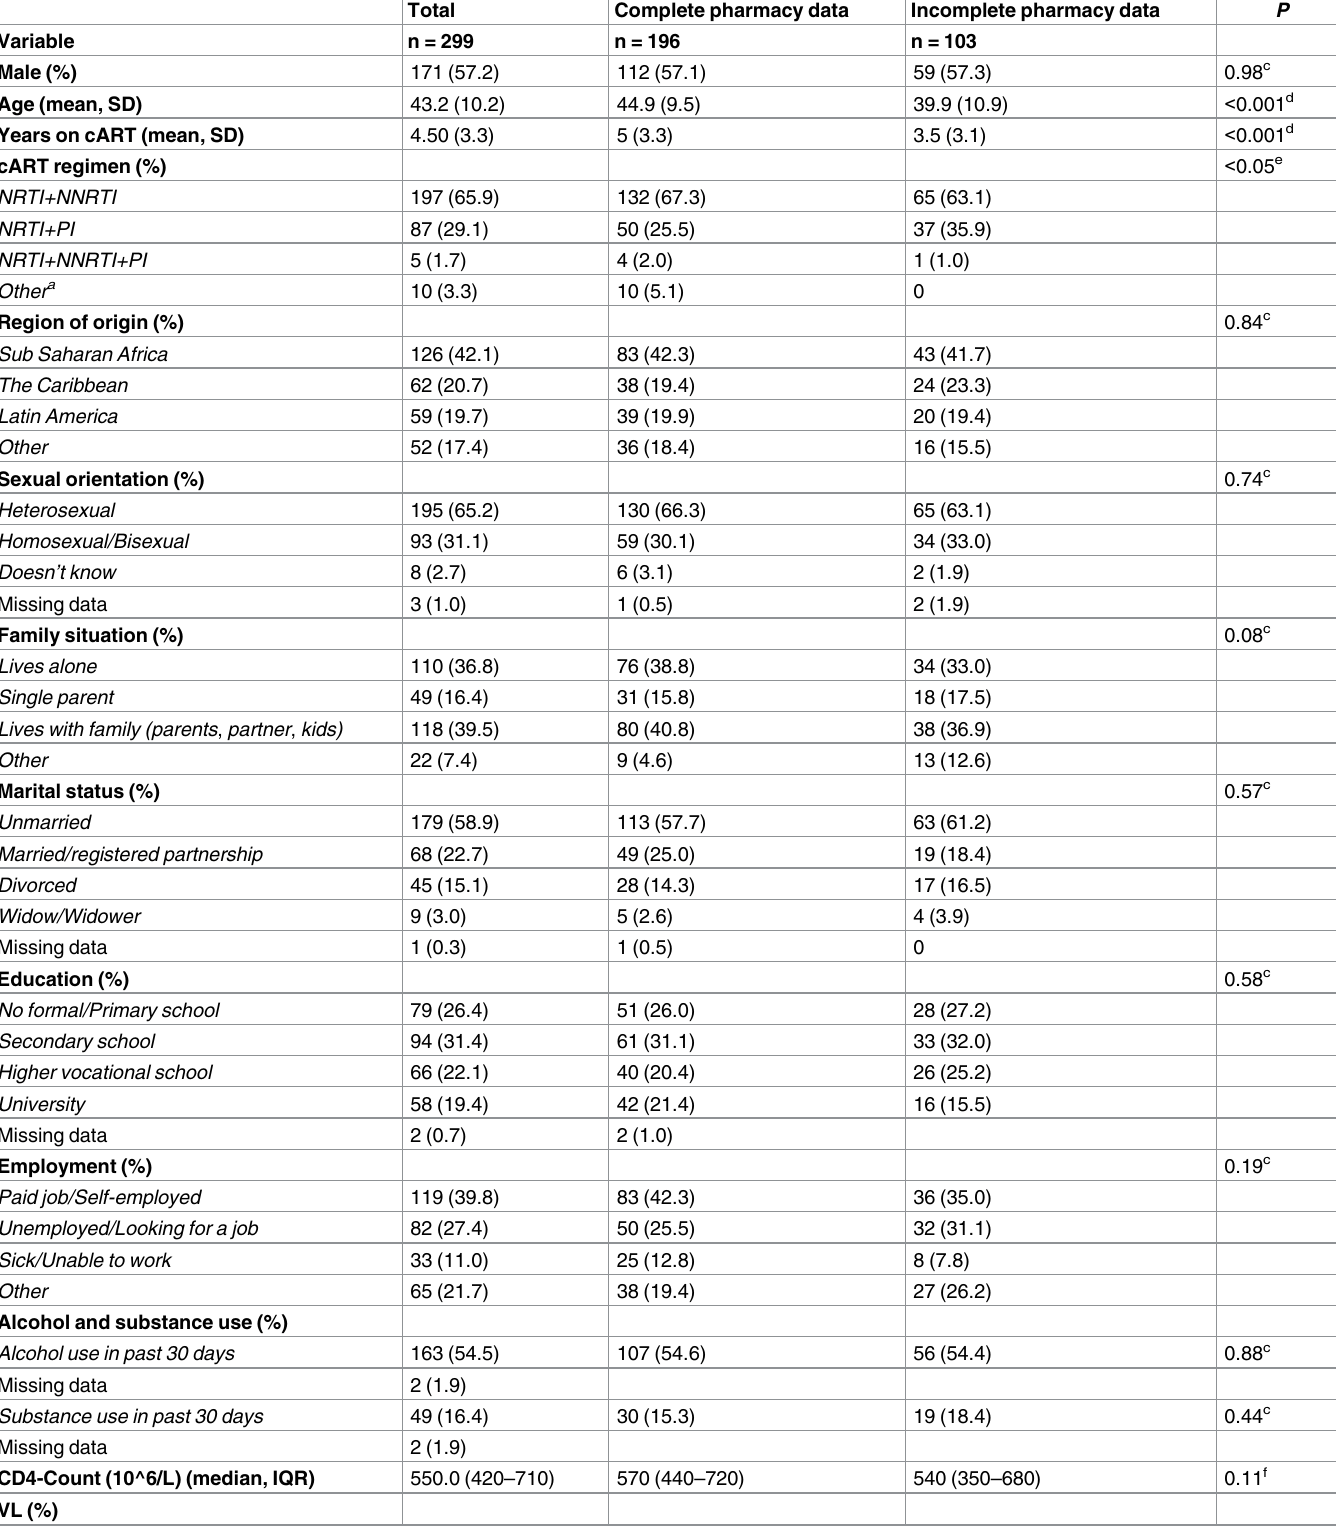
Table 1. Patient